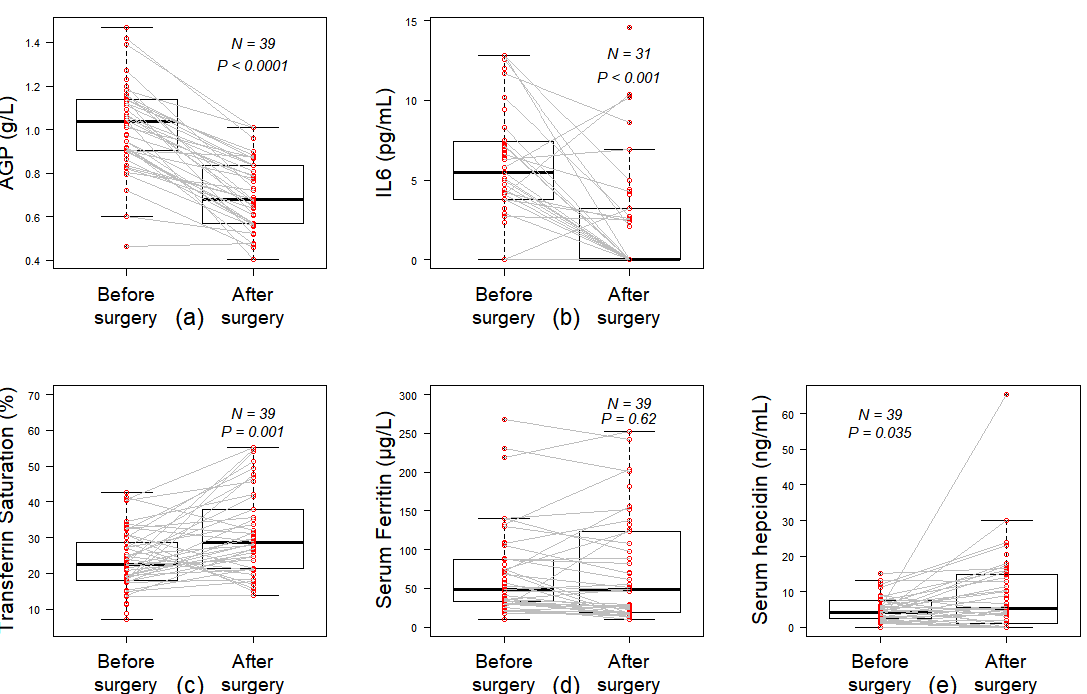
Figure 2. Inflammatory state and iron balance. Paired comparison of pre- and post-operative inflammatory markers values: ( a ) alpha-1 acid glycoprotein (AGP, g/L), ( b ) interleukine-6 (IL6, pg/mL) and iron metabolism markers values: ( c ) serum ferritin (µg/L), ( d ) transferrin saturation rate (TS, %) and ( e ) serum hepcidin concentration. Wilcoxon paired test. Table 2. Biological markers’ evolution before and after surgery on the population of 55 patients.